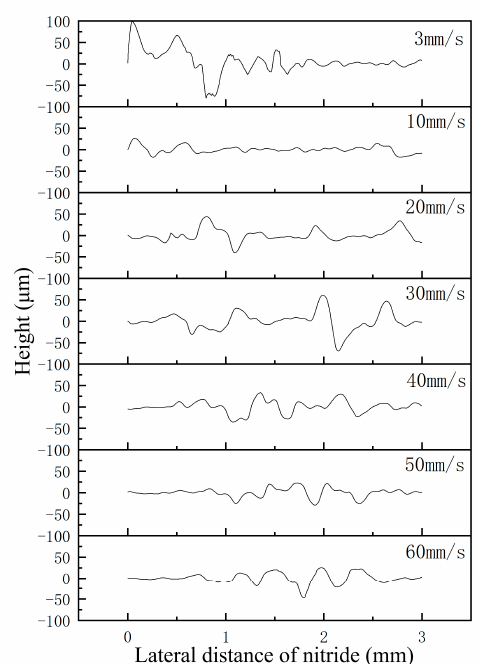
Figure 5. The two-dimensional contour morphology of the nitride layer’s surface in Figure 2b.